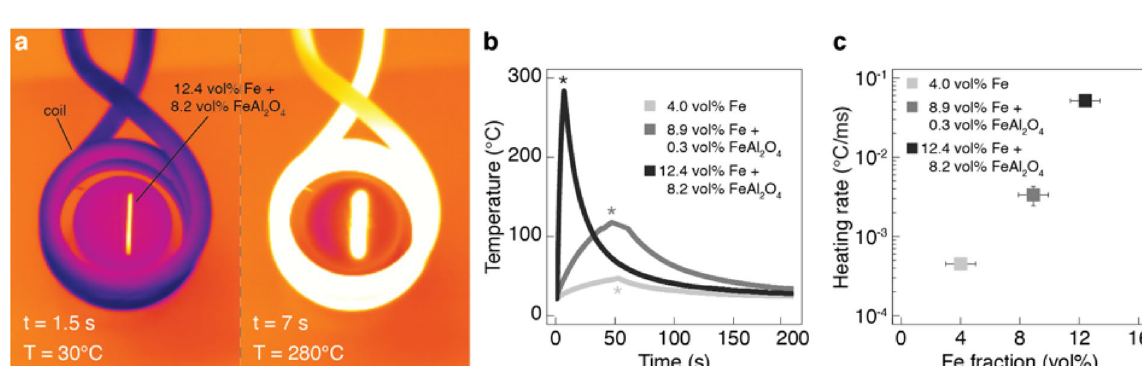
Figure 6. Inductive heating behavior of the metal-ceramic composites upon exposure to oscillating magnetic fields. ( a ) Pictures showing the coil used to generate the magnetic fields and the position of the specimen in the beginning of an experiment (left) and when it reached the peak temperature (right). ( b ) Temperature recorded over time during the inductive heating experiment performed with specimens of different iron fractions. In this experiment, the magnetic field was turned on at time zero and was switched off at the time points indicated with a star symbol inside the plot. ( c ) Average heating rate of composites with varying volume fraction of iron ( b